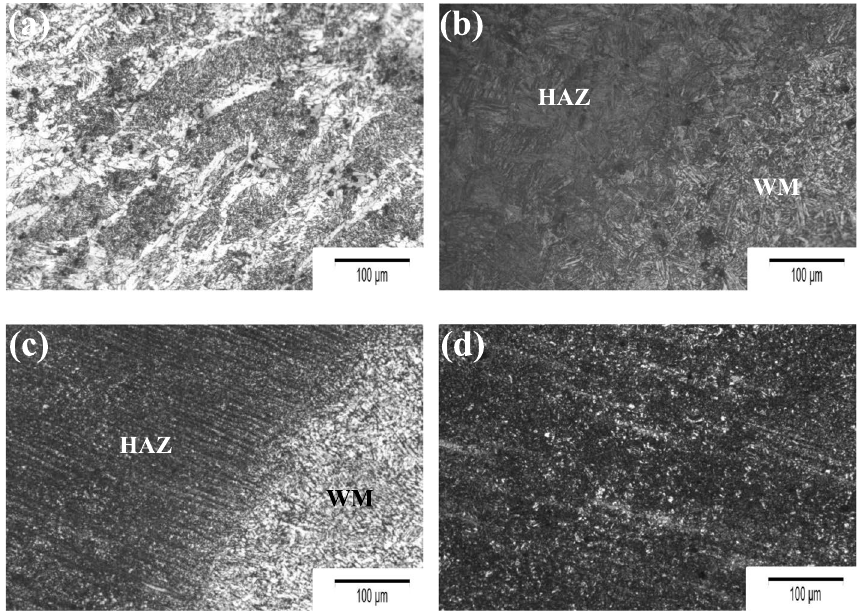
Fig. 21 Microstructure of single bevel welded joint using AWS A 5.18 ER70S-6 filler metal. a Weld metal. b Weld metal at the root pass and HAZ region. c Weld metal zone at the upper pass and HAZ region. d Over-tempering (softening zone) in HAZ